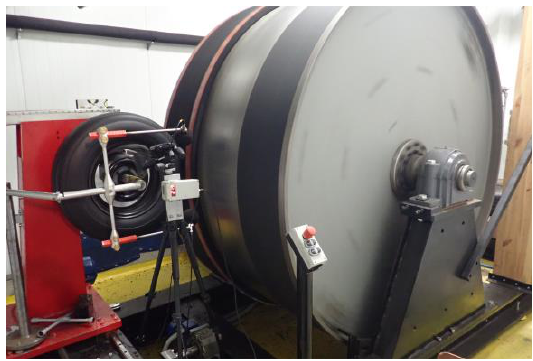
Figure 33. Test trailer Tiresonic Mk.4.